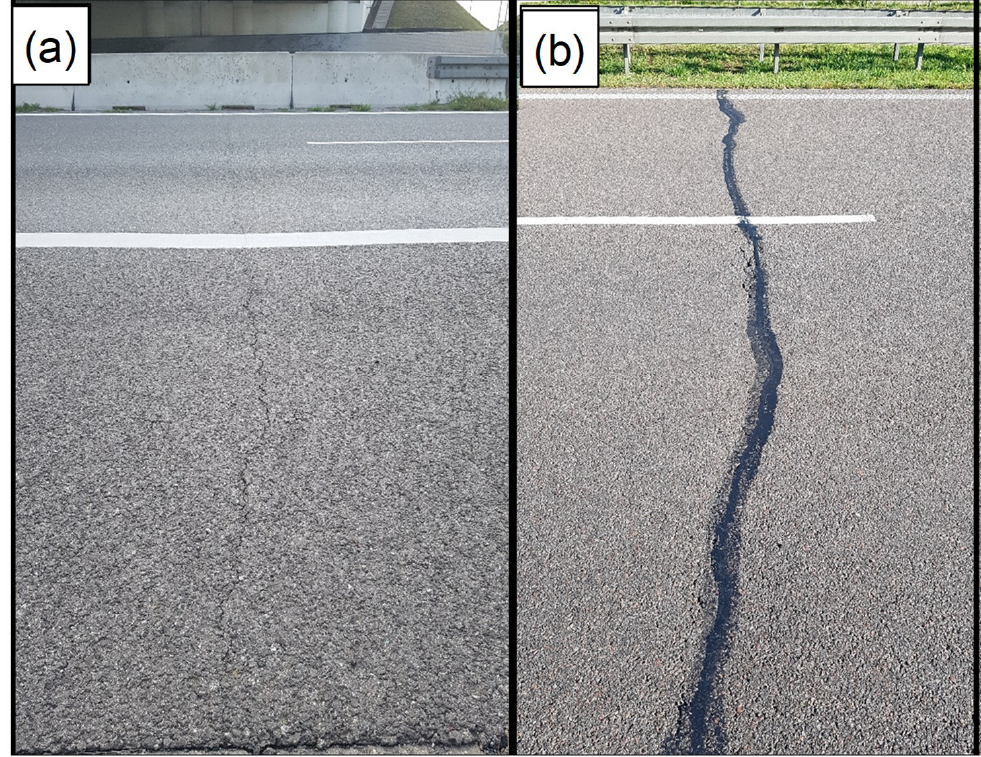
Figure 3. Examples of low-temperature cracks. ( a ) Unrepaired; ( b ) Sealed (Expressway S8).